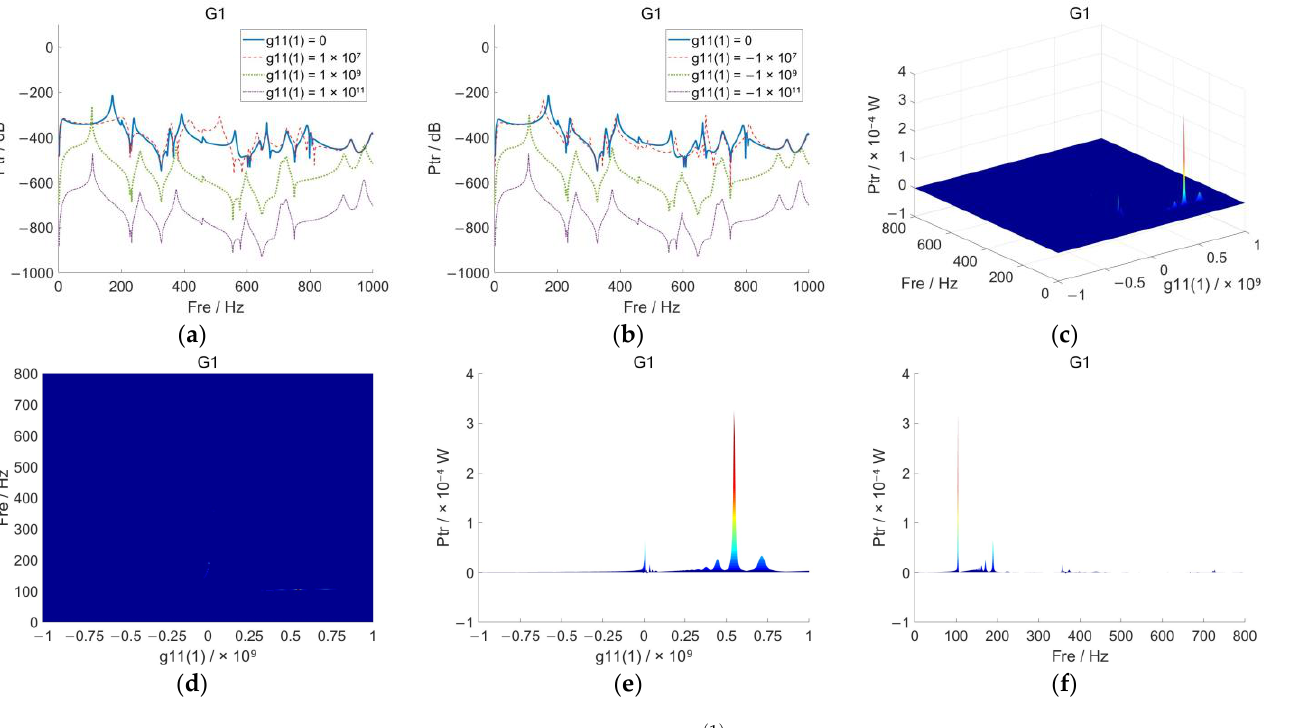
( f ) Figure 3. The 2D view and 3D view of ( ) 2 11 g — Fre — tr P under the absolute velocity feedback control method ( ( ) ( ,  − , the step size is set to 1 × 10 2 ): ( a ) comparison of tr P curves under ( ) 2 11 0 g 